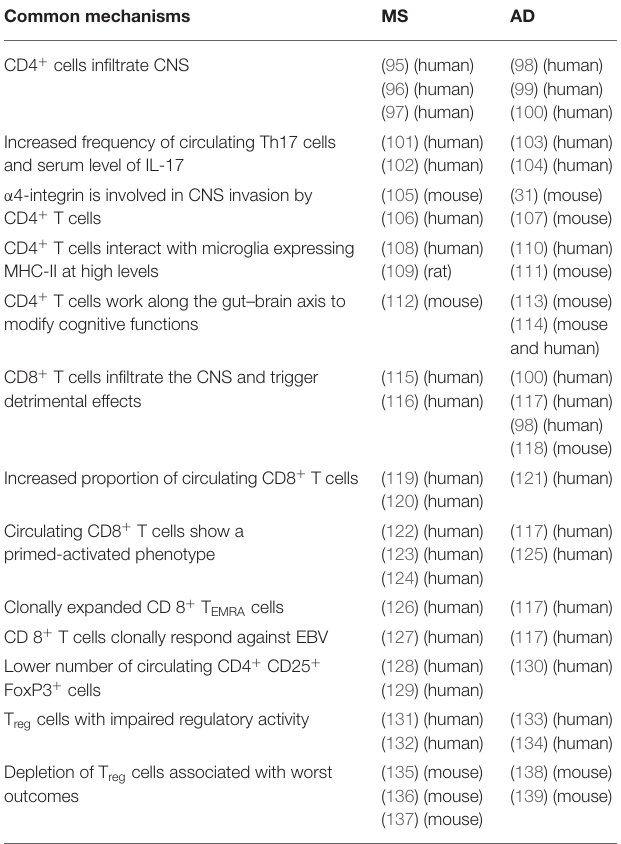
TABLE 2 | Summary of common pathways in the adaptive immune system during the development of MS and AD. Common